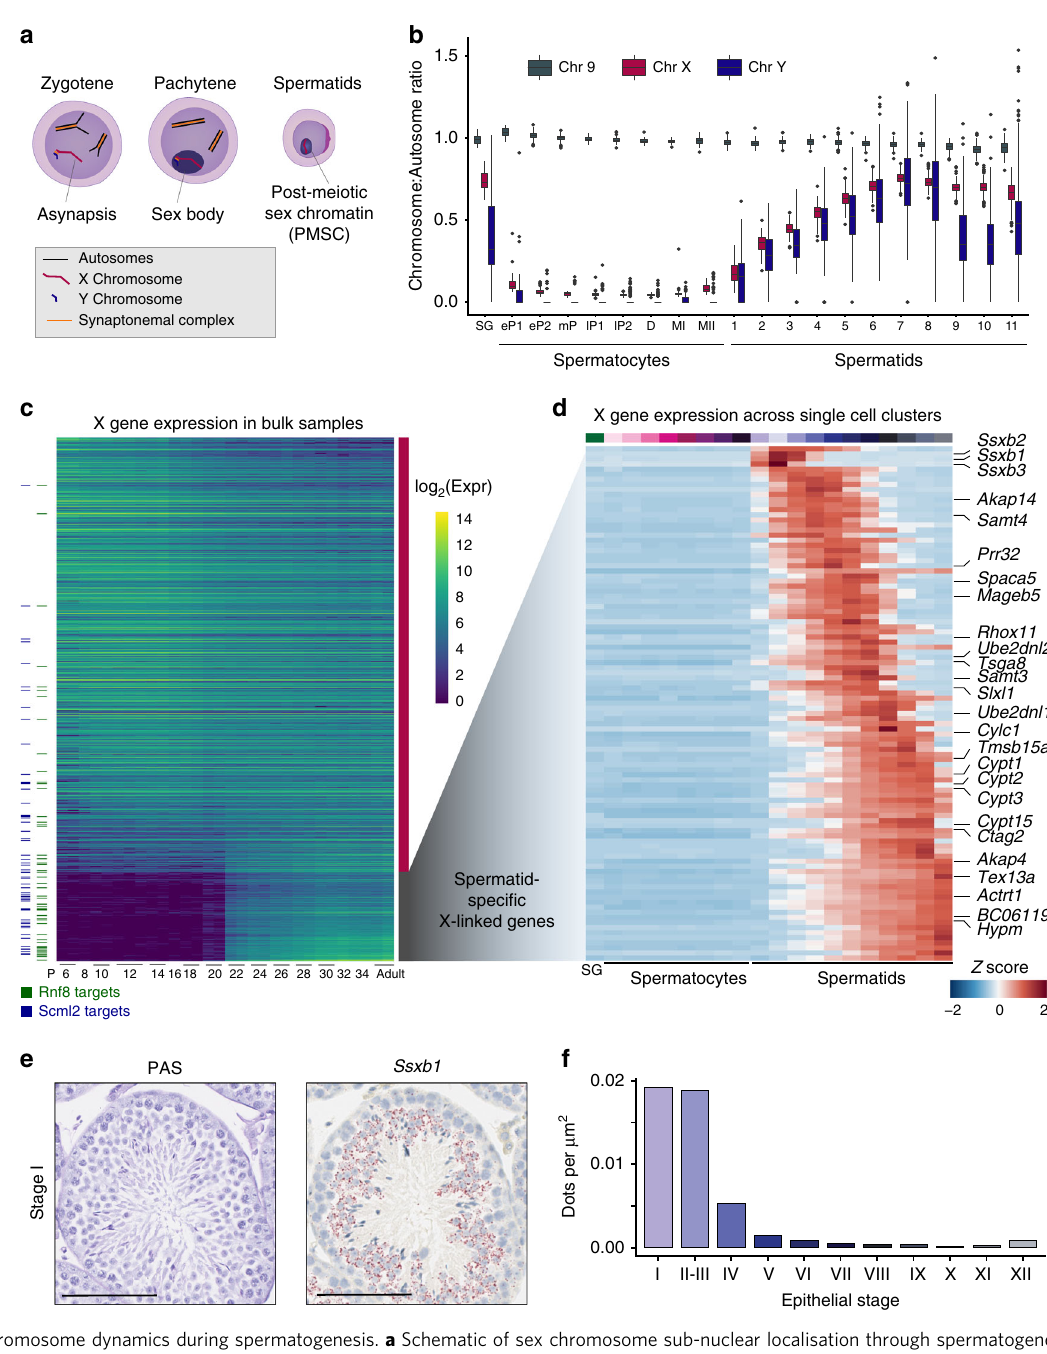
Fig. 7 X chromosome dynamics during spermatogenesis. a Schematic of sex chromosome sub-nuclear localisation through spermatogenesis. b For each cell, the ratio of mean expression of genes on Chr 9, Chr X and Chr Y to the mean expression of genes across all autosomes is represented as a boxplot for cells allocated to each developmental stage (see Methods). SG: spermatogonia, eP: early-pachytene spermatocyte, mP: mid-pachytene, SC: lP late- pachytene SC, D: diplotene SC, MI: meiosis I, MII: meiosis II, S1-11: step 1 – 11 spermatids. c Expression of all X chromosome genes (>10 average counts) in bulk RNA-seq data across the juvenile time-course. Columns correspond to developmental stage and rows are ordered by the log 2 -fold change between spermatocytes (stages before postnatal day (P) 20) and spermatids (stages after and including P20). Horizontal dashes indicate genes that are targets of RNF8 (green) and SCML2 (blue) 52 . The colour scale indicates the log2-transformed, normalised expression. d Normalised expression values of spermatid- speci fi c genes ( c ) were averaged per germ cell-type prior to scaling ( Z score). Columns are ordered by developmental stage and rows are ordered by peak gene expression through development. e Representative images of Stage I tubules from adult B6 animals stained with PAS or RNA ISH for Ssxb1 using RNAScope. Scale bar represents 100 µ m; original magni fi cation ×20. f Quanti fi cation of RNAScope dots for Ssxb1 per µ m 2 within tubules at different epithelial stages. A total number of 217 tubules was quanti fi ed across entire tissue cross-section from adult B6 animal. Source data are provided as a Source Data fi